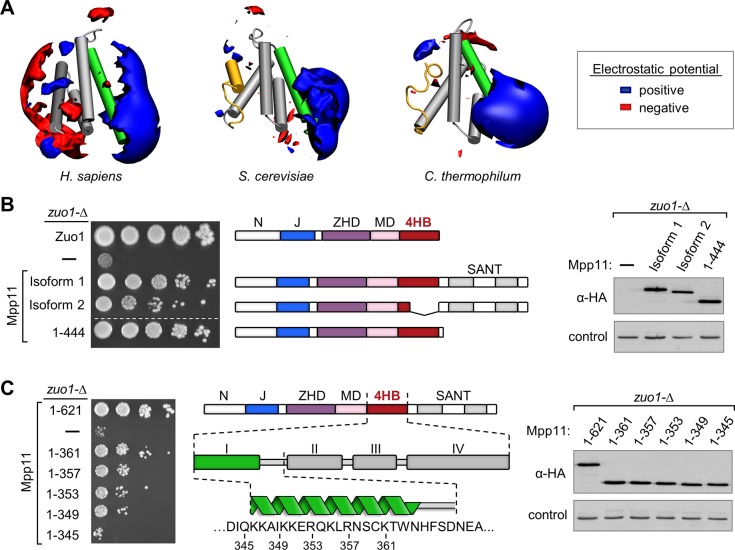
Functional importance of conserved Helix I of the 4HB.(A) Electrostatic isopotential contour maps (blue +2, red -2 kT/e) around the 4HB structures. Helix I in green, hydrophobic plug in the two fungal structures in gold. (B and C) Analysis of the ability of Mpp11 variants to support growth of S. cerevisiae zuo1-Δ cells. (left) zuo1-Δ strains expressing Zou1, HA-tagged Mpp11 or indicated truncated variants were 5-fold serially diluted, spotted on paromomycin-containing plates and incubated at 30°C for 5 (B) or 6 (C) days. (middle) Schematic representation of domain composition of Zou1, Mpp11 and Mpp11 truncation variants. (right) Cell lysates made from indicated strains were subjected to immunoblot analysis using HA-tag specific, or as a control, Ydj1 specific antibodies. Number of residues present in Mpp11 truncation variants are indicated. Two isoforms of Mpp11 identified in humans were tested in C: Isoform 1, “full-length” Mpp11, residues 1–621 and isoform 2 which lacks codons for residues 362–414, which encode Helices II and III, as well as part of Helix IV. Dotted line in B indicates that a strain not relevant to this manuscript was spliced from the image of the plate.